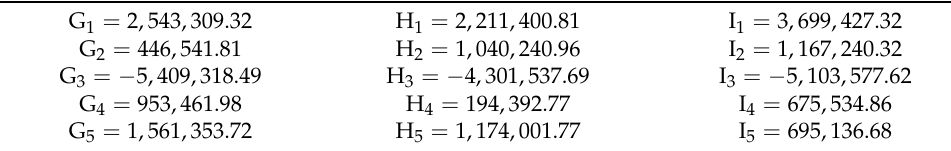
Table 2. Coefficients of the Equations (4)–(6) for the SP. G 1 =